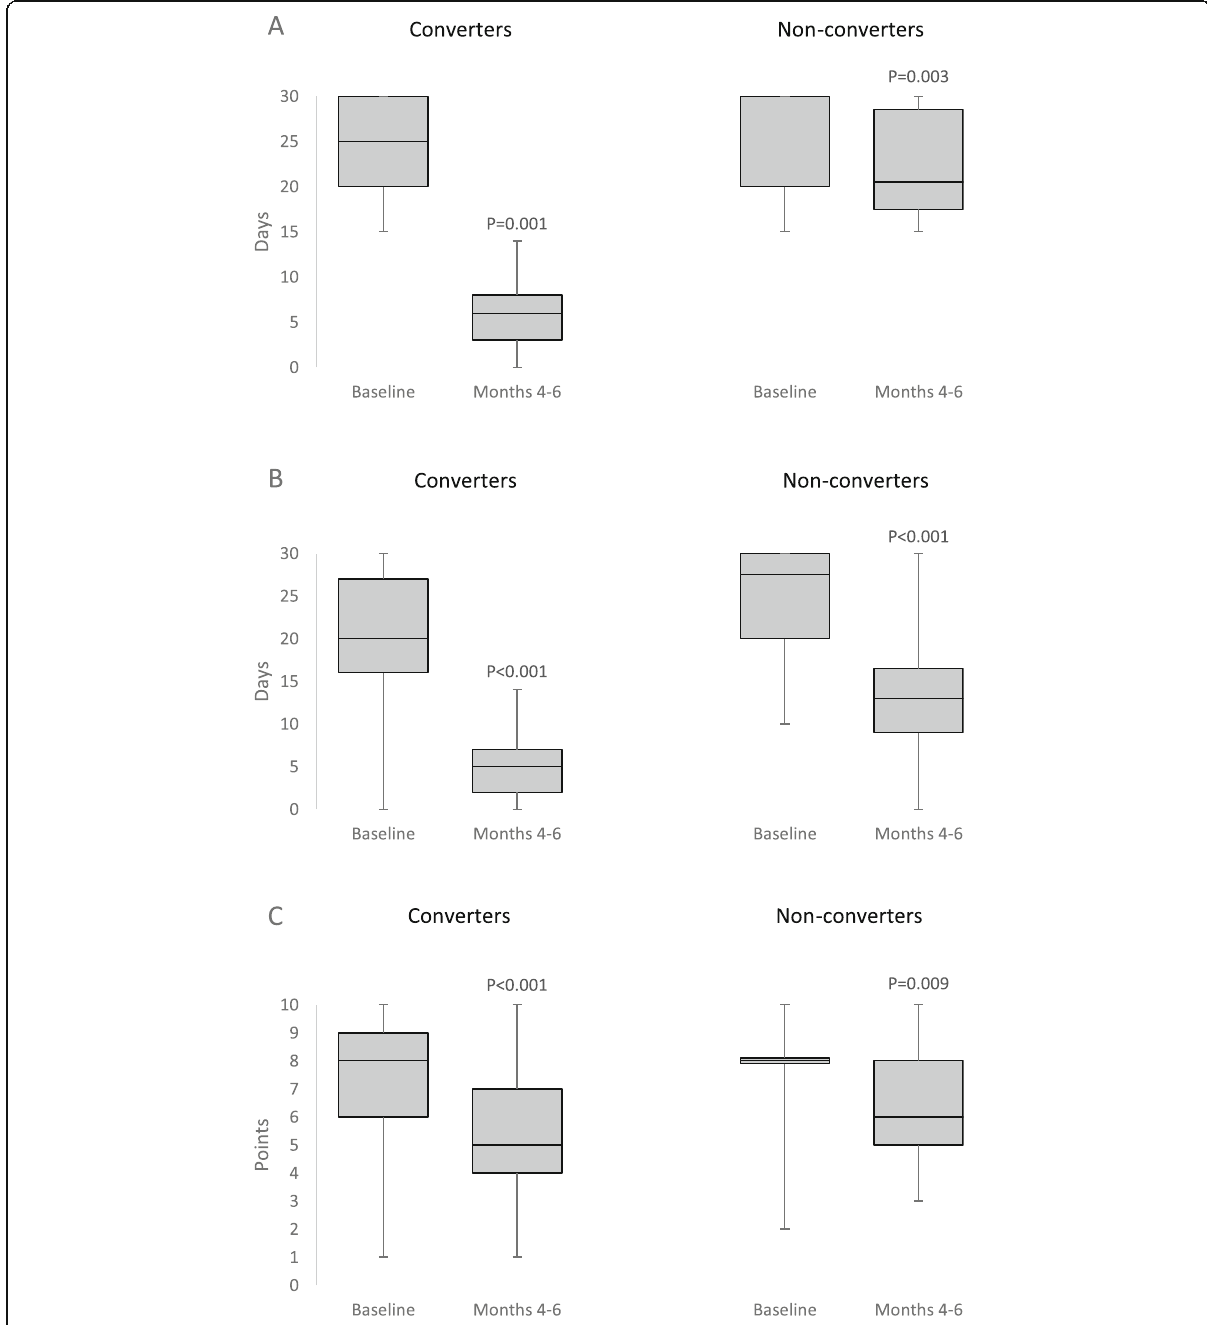
Fig. 2 Decrease in median headache days a , acute medication days b , and headache intensity on a Numerical Rating Scale c according to converter status in the present